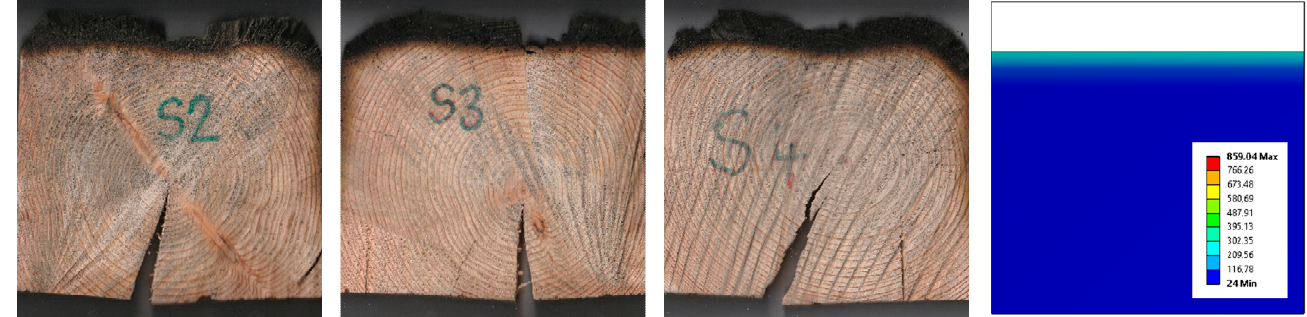
Figure 8. Cross section of samples: comparison of results from medium scale fire tests and simula- tion.